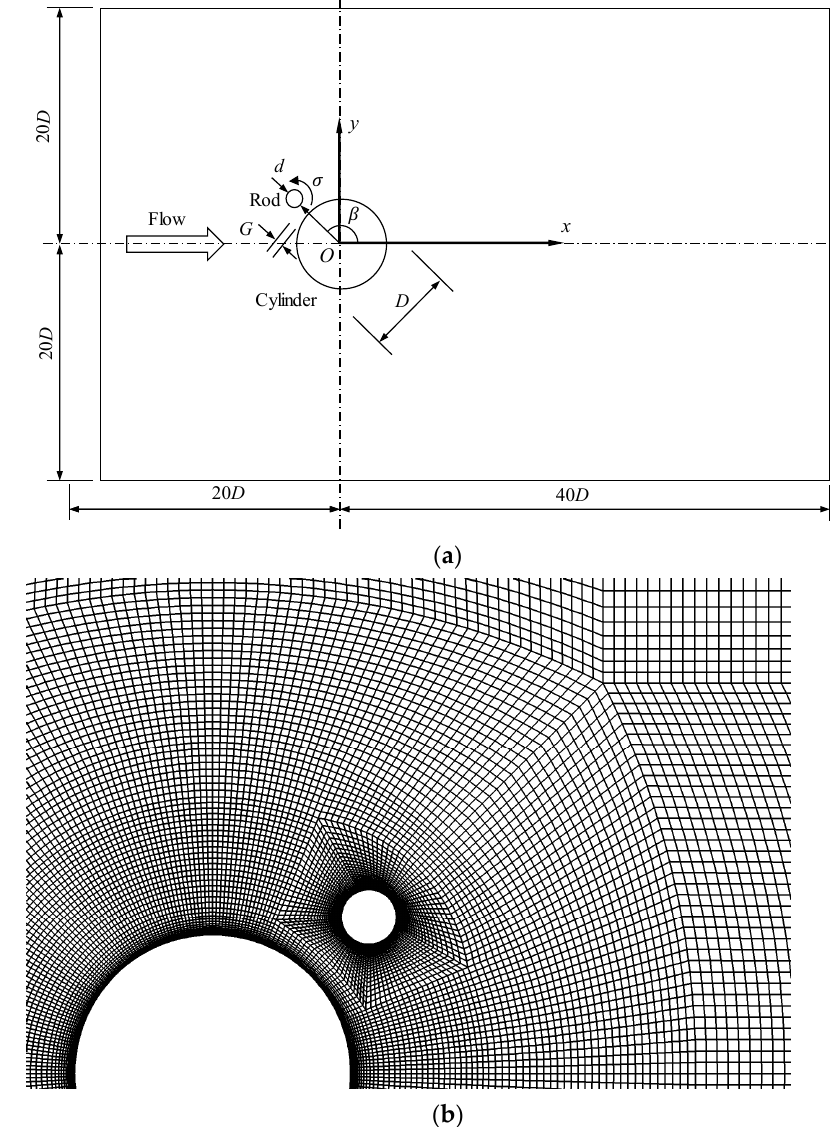
Figure 1. ( a ) Sketch of flow past a cylinder with a rotating control rod; ( b ) computational mesh near the cylinder and rod for β = 45°.